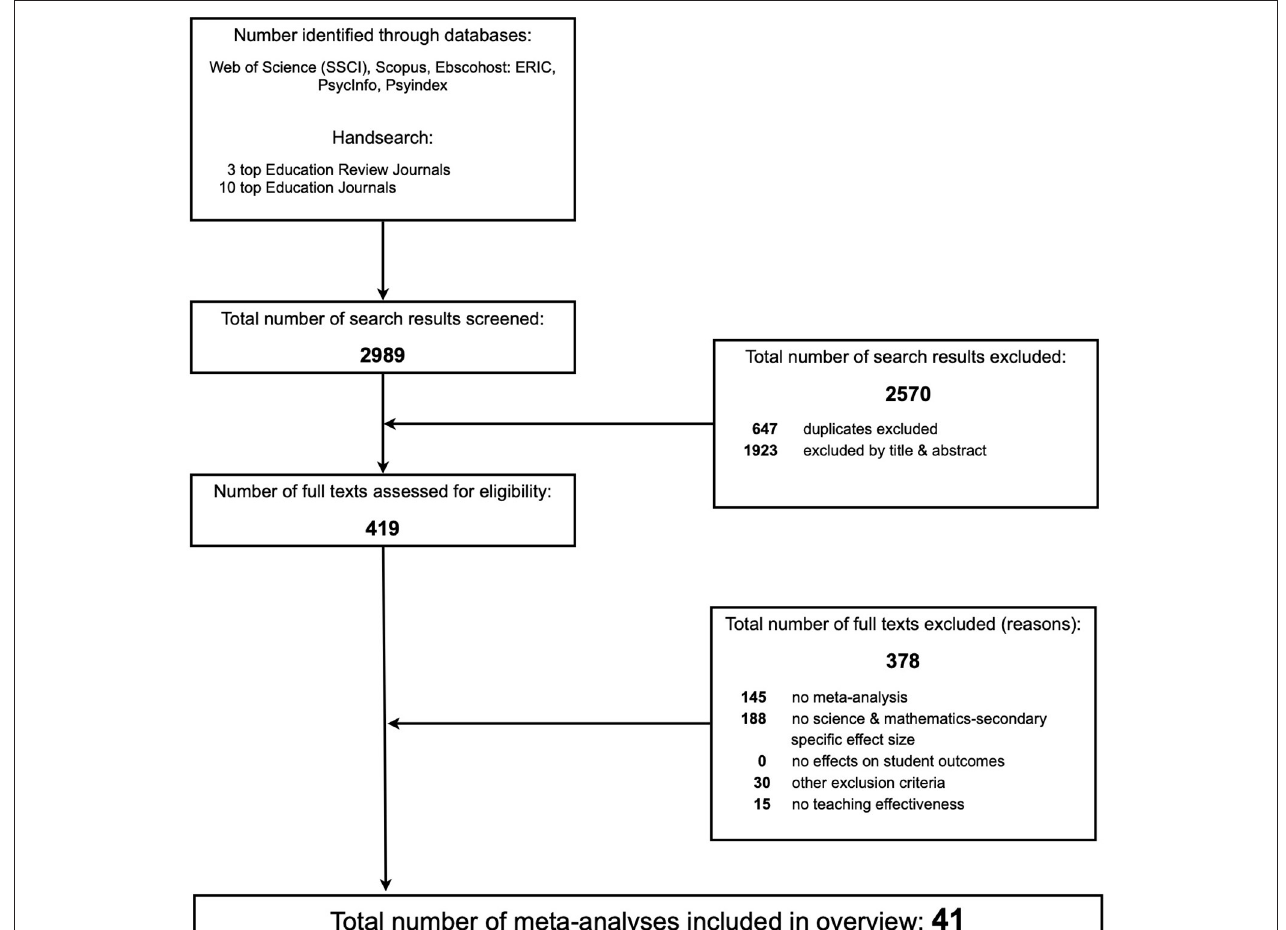
FIGURE 1 | PRISMA flow